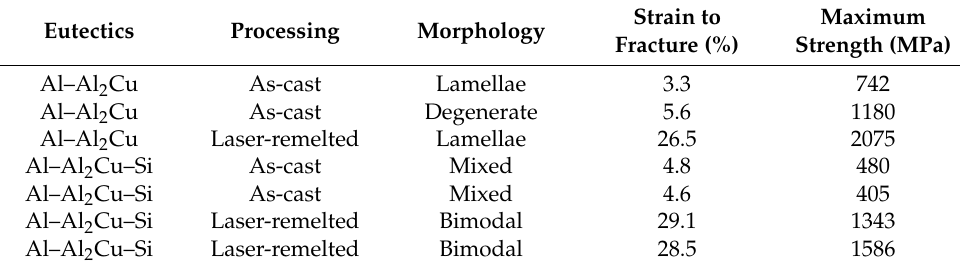
Table 1. Microstructure and compressive properties of the studied eutectic alloys.